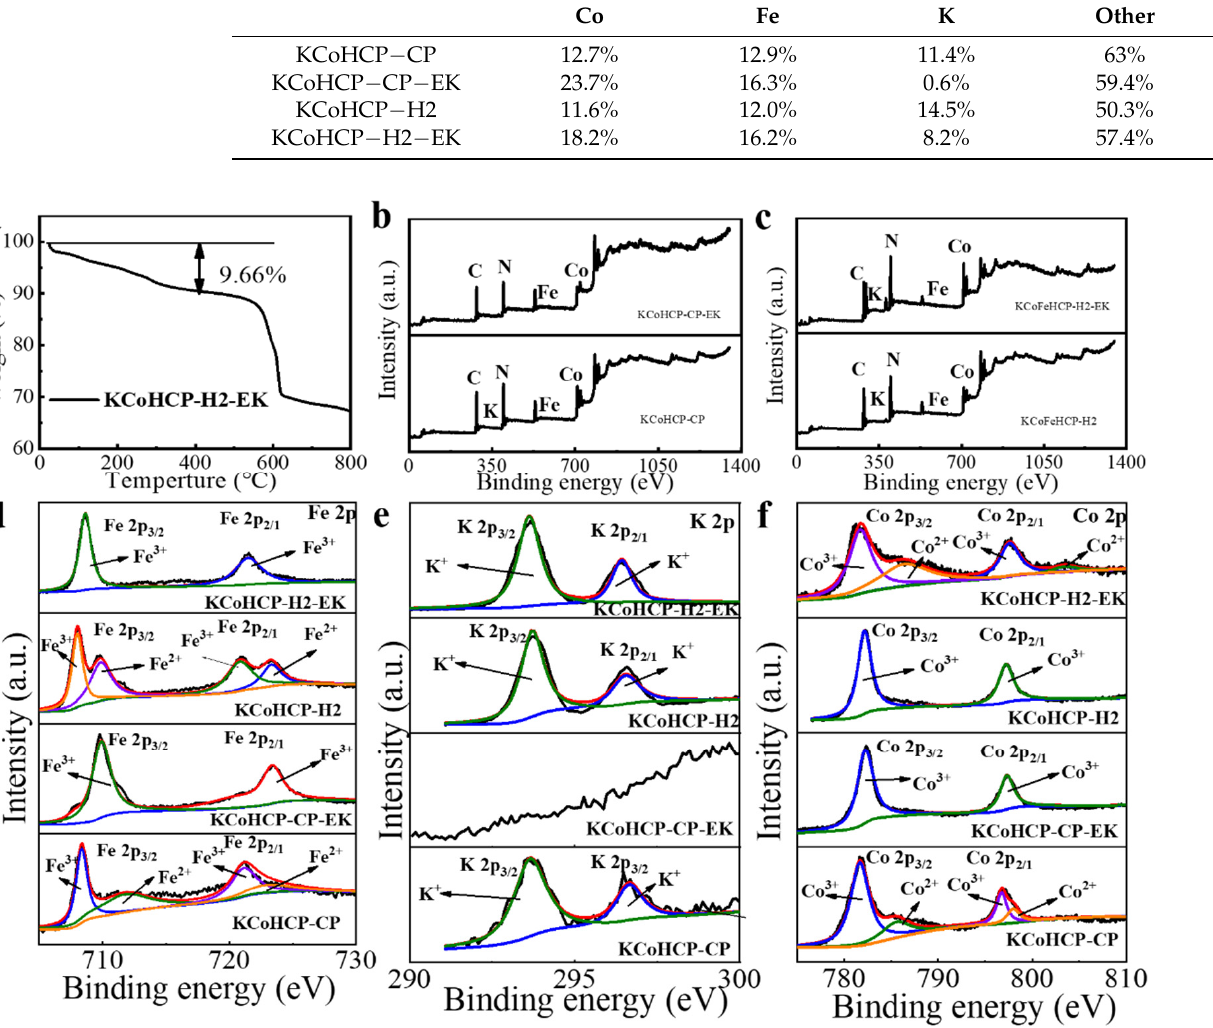
Figure 3. The analysis of thermogravimetric and surface chemical bonds: ( a ) The thermogravimetric curve of KCoHCP − H2 − EK; ( b – f ) XPS spectras of KCoHCP − CP, KCoHCP − CP − EK samples and KCoHCP − H2, KCoHCP − H2 − EK samples.